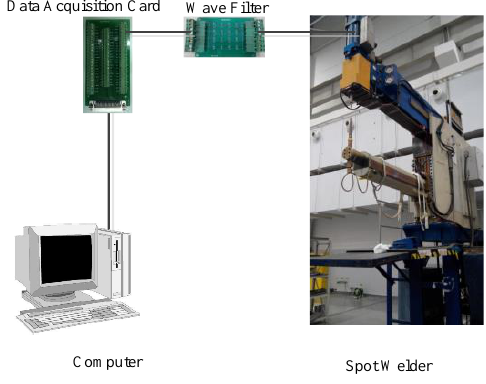
Figure 2. Signal acquisition system.